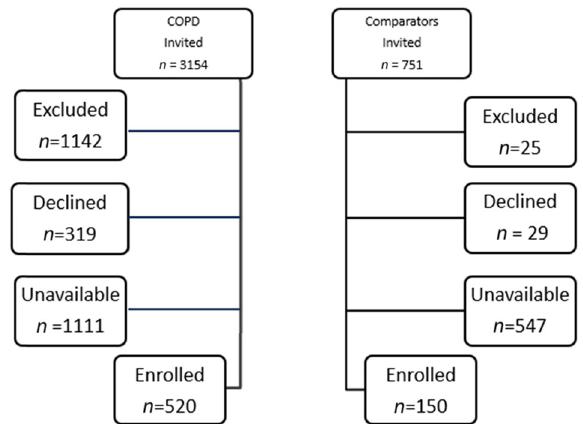
Fig. 1 A fl ow chart describes the process of recruitment and enrollment of patients with COPD and controls. A fl ow chart describes the process of